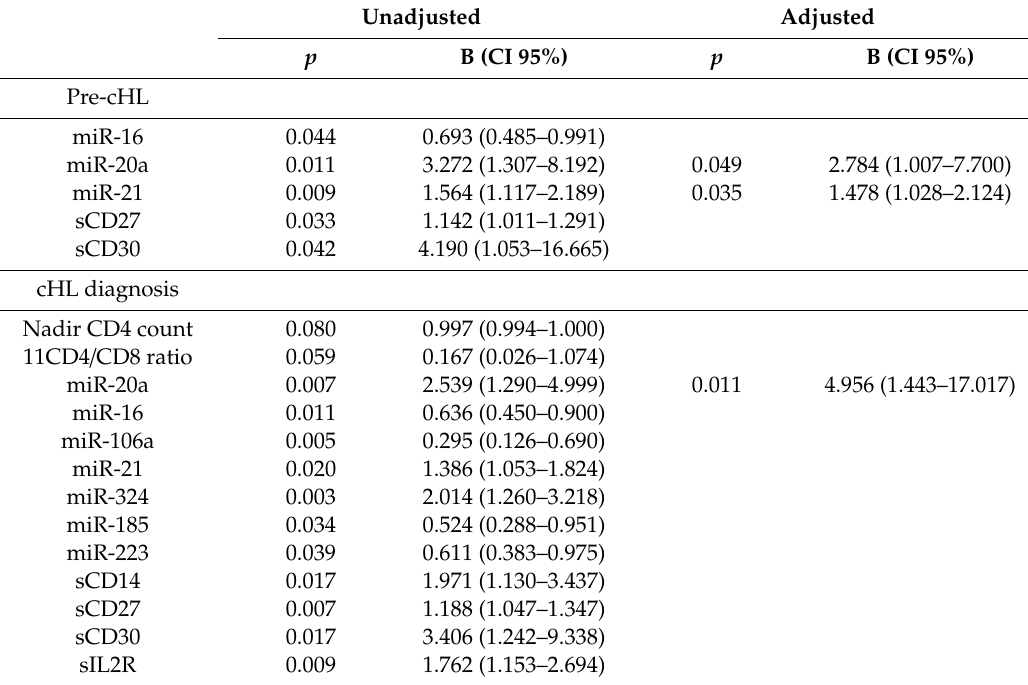
Table 4. Uni (unadjusted) and multivariate (adjusted) analysis at pre-cHL and cHL diagnosis of biomarkers association with cHL.